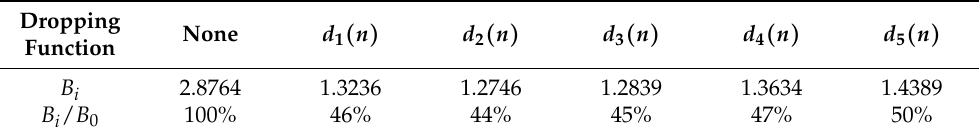
Table 1. Burst ratio B i for i -th dropping function in the first row. In the second row, B i is a percentage of B 0 .